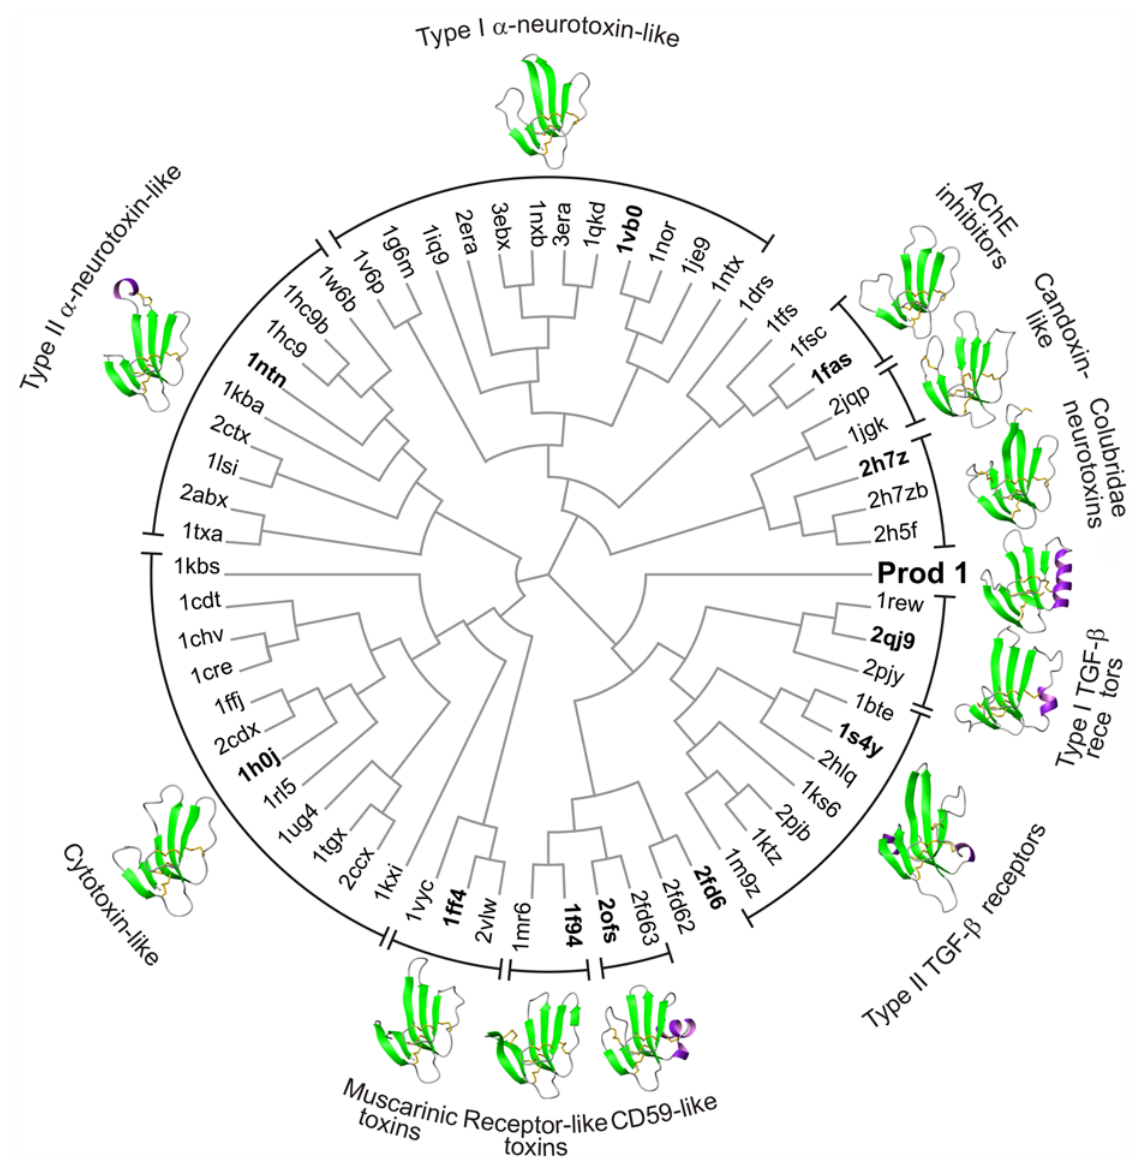
Figure 3. Structure-based phylogenetic tree of TFP domains. The tree was computed using BioNJ and a matrix of pairwise structure distances derived from phenotypic plasticity method (PPM) similarity scores. PDB codes in bold correspond to the structure adjacent structure shown in ribbon representation.